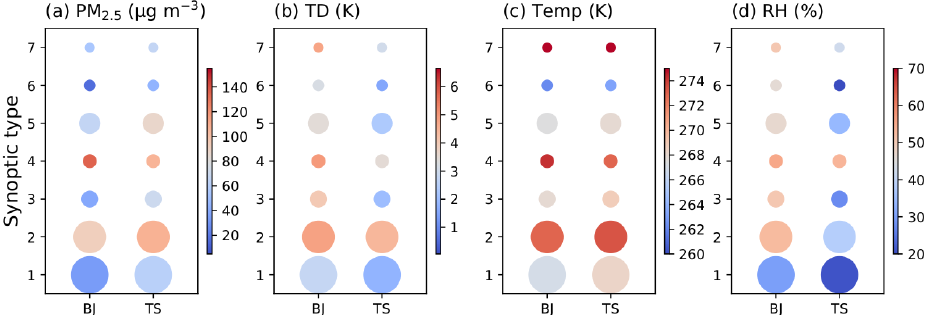
Figure 4. (a) Average PM 2 . 5 concentrations under different synoptic conditions in Beijing and Tangshan, associated (b) thermal differences (TDs) in PT between 100 and 1000m, (c) temperature at 1000m, and (d) relative humidity (RH) at 200m. The TD equals PT at 1000m minus PT at 100m. The size of the circle represents the occurrence frequency of each synoptic type. All of the meteorological variables shown are derived from the radiosonde data.